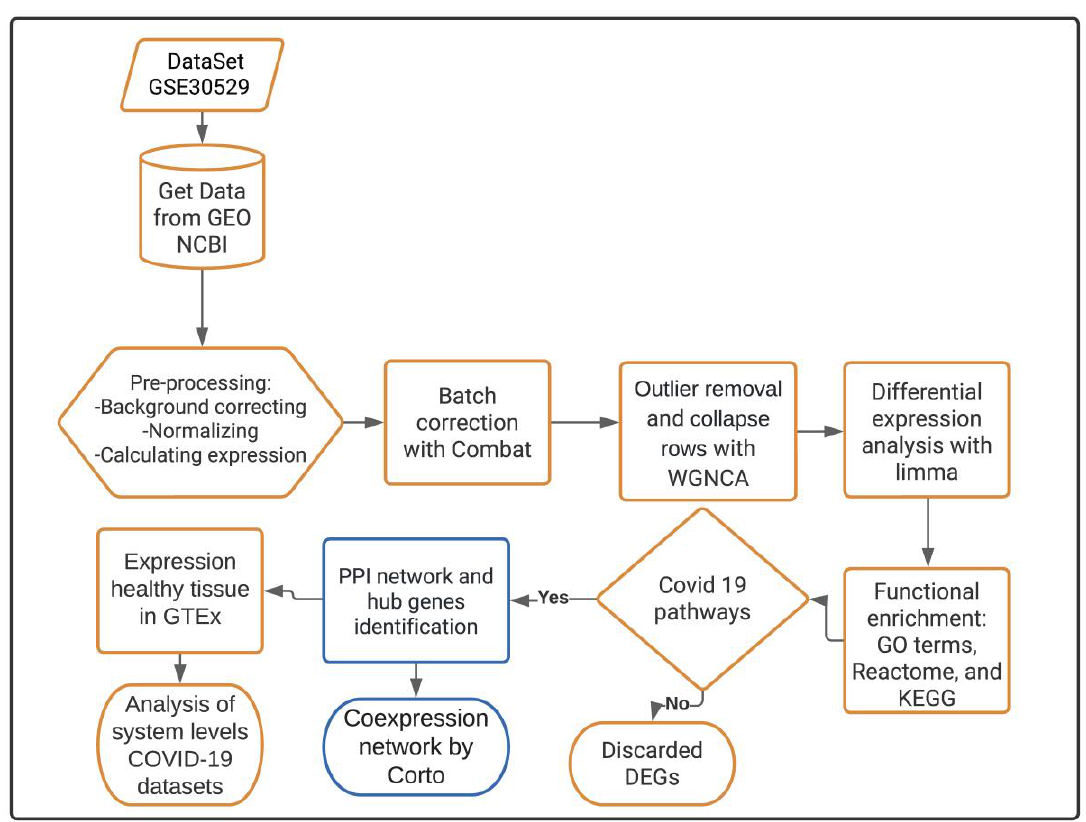
Figure 1. Bioinformatics pipeline for obtaining predictive hub genes involved in the pathophysiological impact of COVID-19 on DKD condition. Highlighted in yellow are the steps to perform the transcriptomics analysis, while those in blue are steps for the interactomics methodology. First, transcriptomic data were acquired from the NCBI GEO database. Data were pre-processed and outlier detection with WGCNA analysis was performed. Then, we obtained the DEGs and determined their potential functional roles in biological and molecular pathways. Those DEGs that overlapped among COVID-19 and DKD pathways were selected and interactome analysis was performed using protein – protein interaction (PPI) associations. Subsequently, the potential hub genes were identified using the Maximal Clique Centrality (MCC) topological algorithm. Then, their co-expressed gene modules were determined using the Corto algorithm. Finally, hub gene expression was validated using analysis of systems levels employing the Coronascape COVID-19 datasets and gene expression value comparisons in healthy tissues using the GTEx